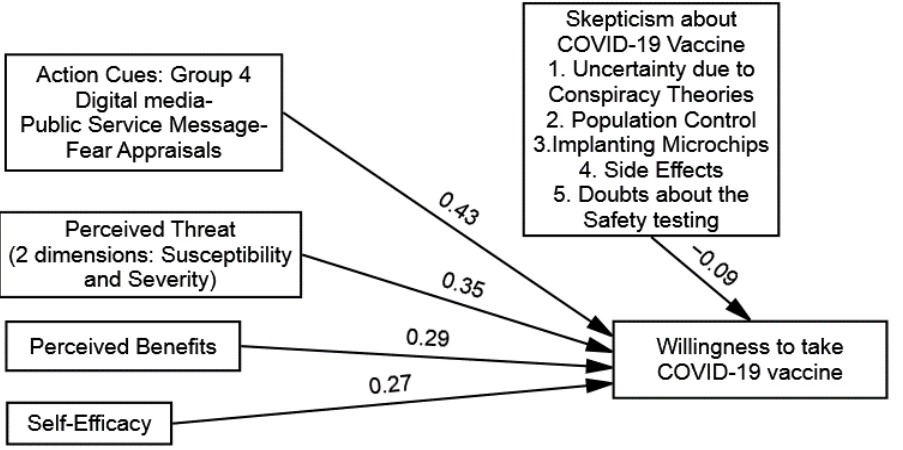
Figure 5. Structural model of group 4: Digital Media–Public Service Message–Fear Appraisals. Table 5. Hypothesis Testing.